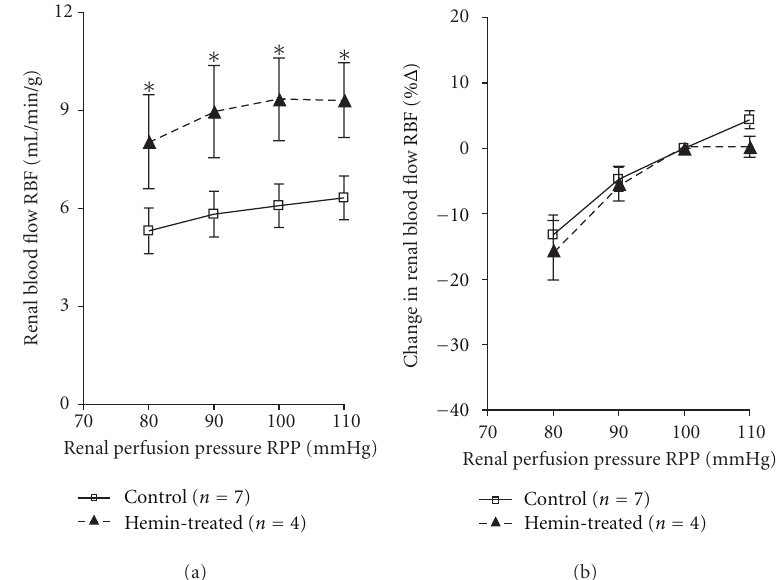
Figure 4: Renal blood flow (RBF) autoregulatory responses to changes in renal perfusion pressure (RPP) in hemin-treated rats ( n = 4) compared to control rats ( n = 7). Results are expressed as mean ± SE for each group, ∗ P < 0 . 05 versus Control.